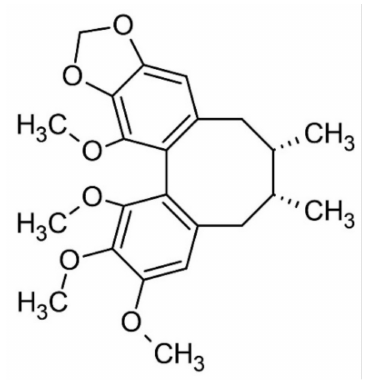
Figure 4. Structure of γ